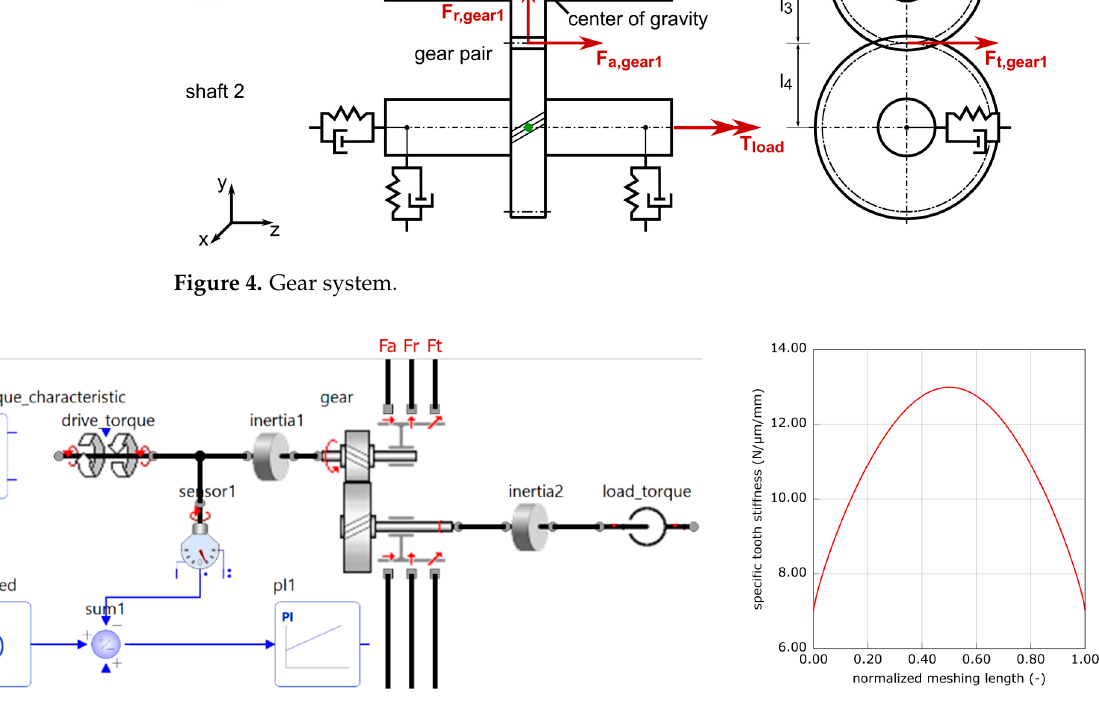
Figure 4. Gear system.